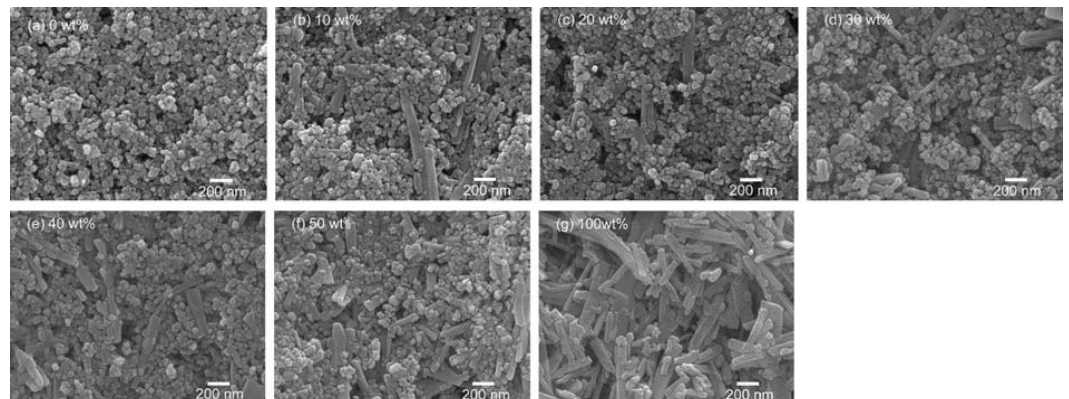
Fig. 6 SEM micrographs of DSC top surface view: TiO 2 anatase nanowire contents are (a) 0 wt%, (b) 10 wt%, (c) 20 wt%, (d) 30 wt%, (e) 40 wt%, (f) 50 wt%, and (g) 100 wt%. (after Ref. [11]).